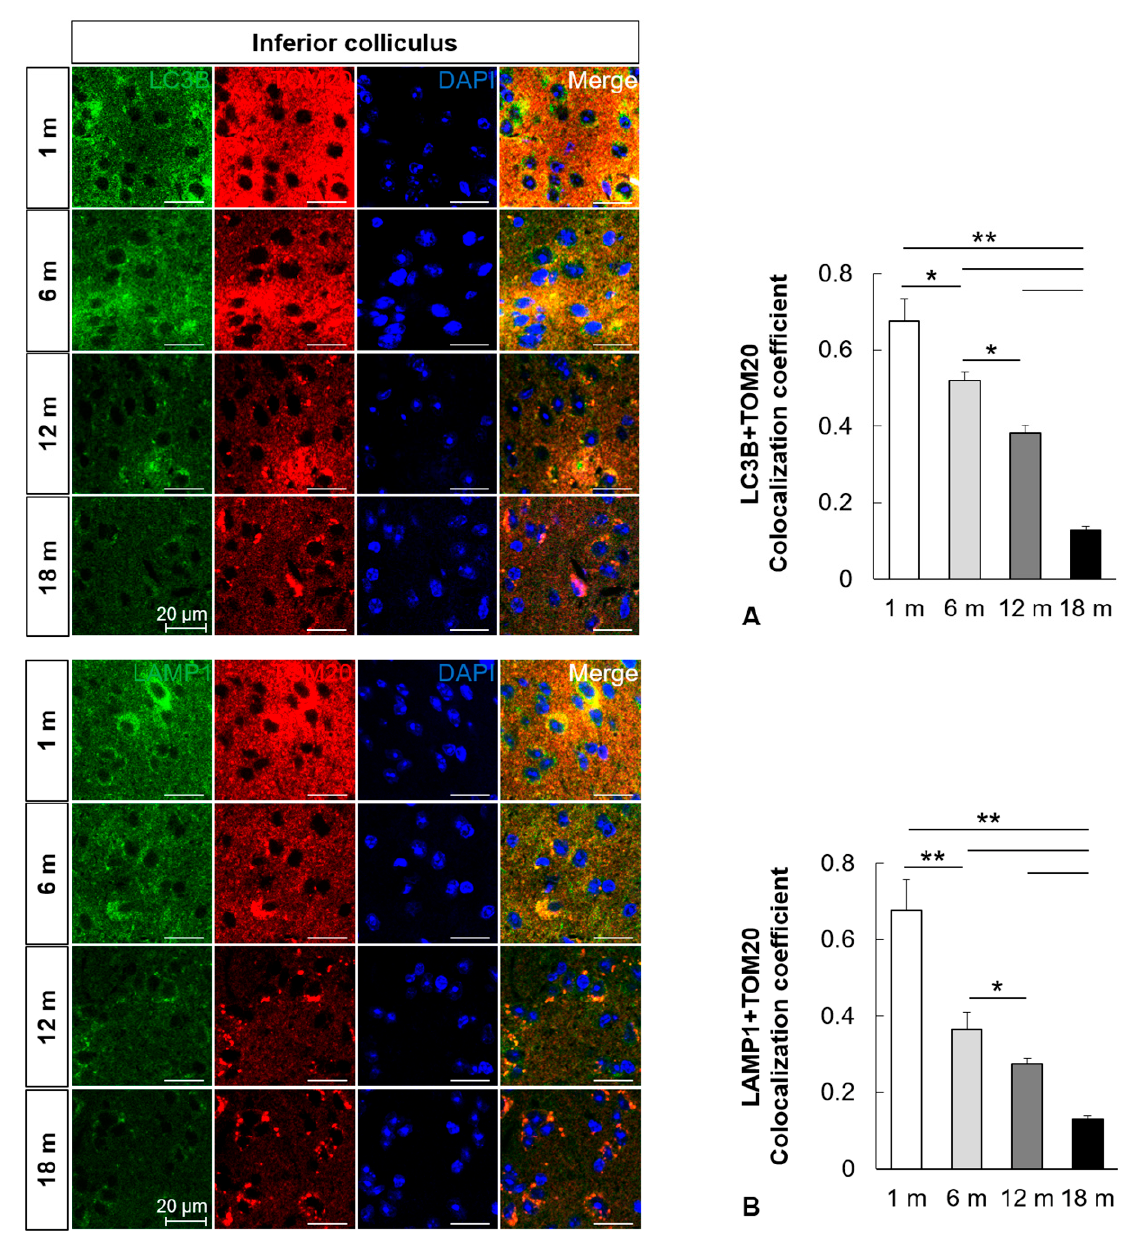
Figure 4. Impairment of mitophagy in the mouse inferior colliculus with aging. ( A ) Colocalization analysis of autophagosomes and mitochondria. Immunofluorescence analysis revealed that the colocalization (yellow puncta, the overlap color) of LC3B (green) and TOM20 (red) in the mouse inferior colliculus significantly decreased with aging. ( B ) Colocalization analysis of lysosomes and mitophagosomes. Immunofluorescence analysis revealed that the colocalization (yellow puncta, the overlap color) of LAMP1 (green) and TOM20 (red) in the mouse inferior colliculus significantly decreased with aging. The data are shown as mean ± standard error of mean (five mice per group; 1 m, 1 month; 6 m, 6 months; 12 m, 12 months; 18 m, 18 months; DAPI, 4 ′ ,6-diamidino-2-phenylindole). * p < 0.05, ** p < 0.01.